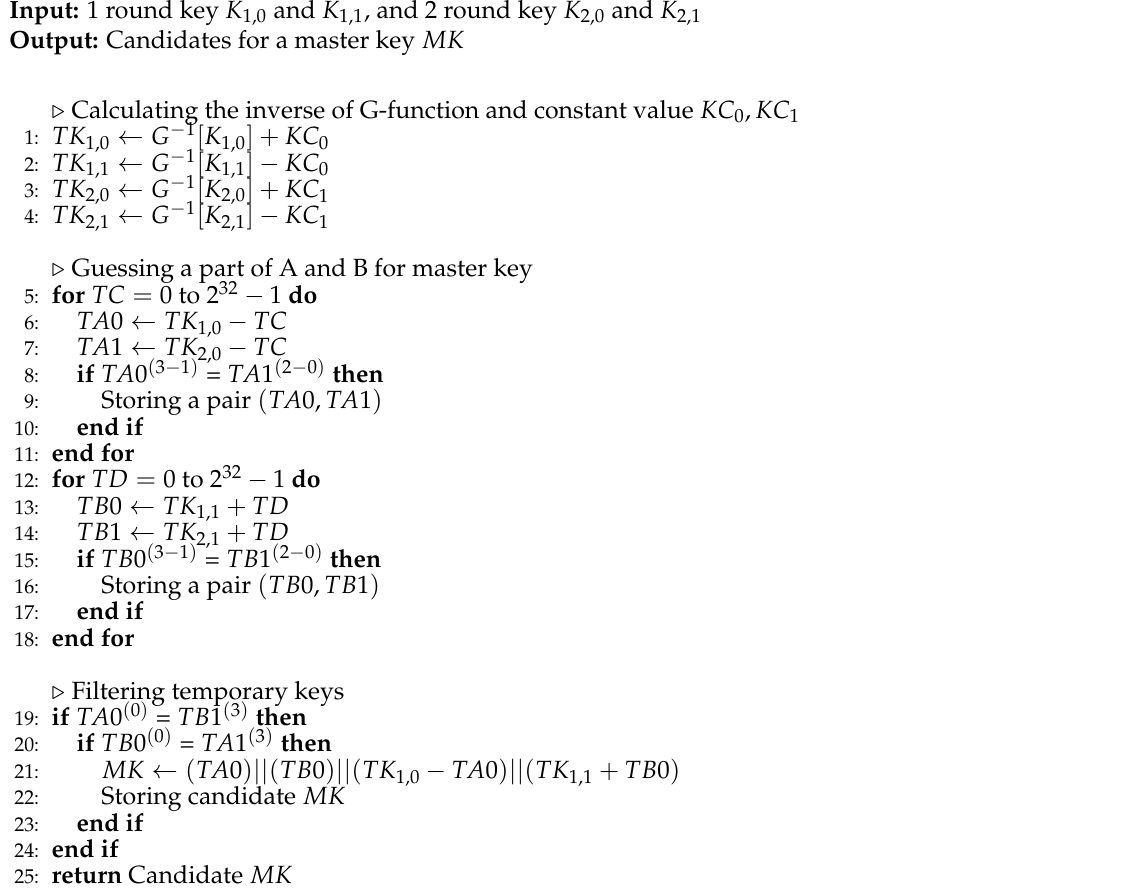
Algorithm 1 Recovery of the master key under two round keys K 1 , K